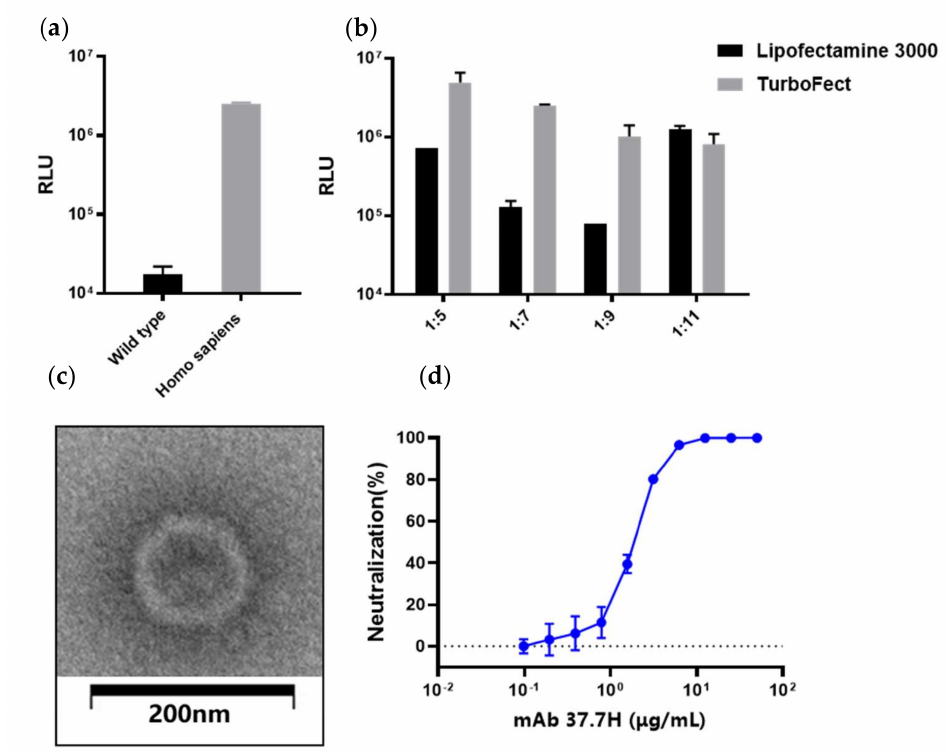
Figure 6. LASV pseudovirus construction and packaging condition optimization. Optimization of the LASV GPC gene ( a ); transfection reagents and the ratio of shuttle vector pDC316-LASV-GPC and human immunodeficiency virus (HIV) backbone plasmid pNL4-3.Luc-R − E − ( b ). ( c ) Electron micrographs of LASV pseudoviruses. The LASV pseudoviruses were imaged after staining with saturated uranyl acetate. Scale bar: 200 nm. ( d ) LASV pseudovirus neutralizing experiment using